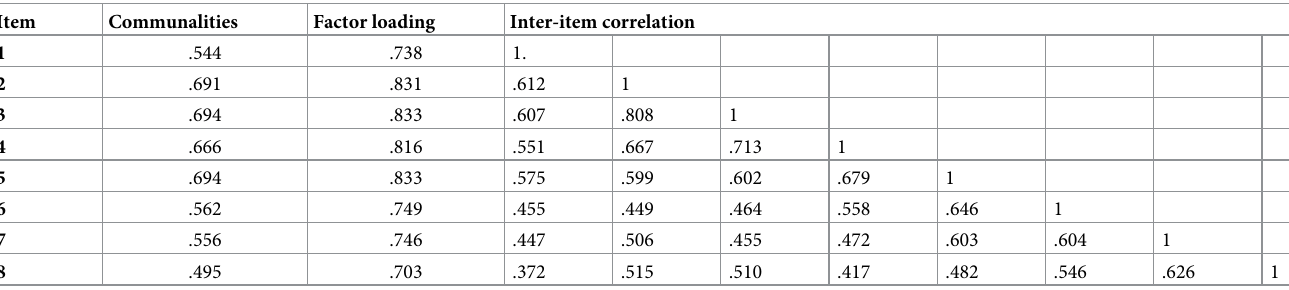
Table 4. Factor analysis and inter-item